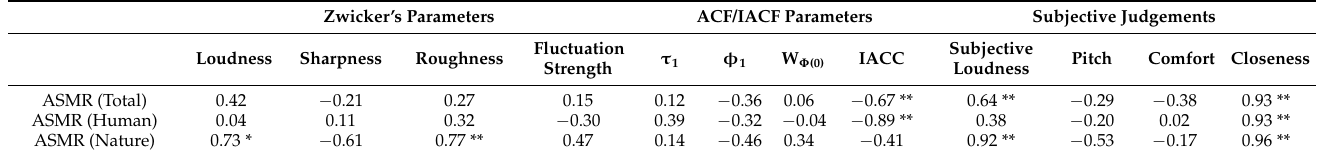
Table 2. Correlation coefficients of the ASMR scores among Zwicker’s parameters, ACF/IACF parameters and subjective judgements (**: p < 0.01, *: p < 0.05).